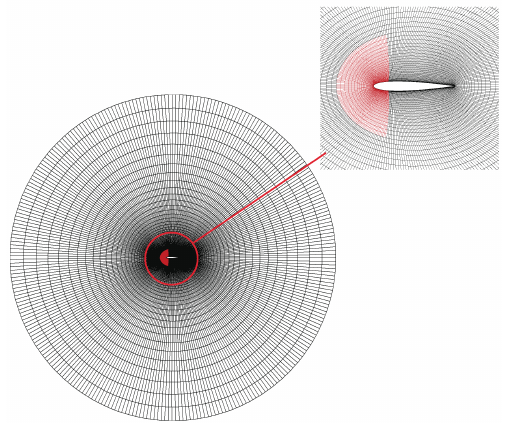
Figure 4. The computational grid. The red grid is the sectorial